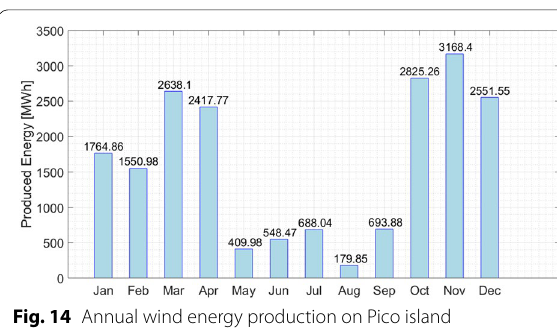
Fig. 14 Annual wind energy production on Pico island